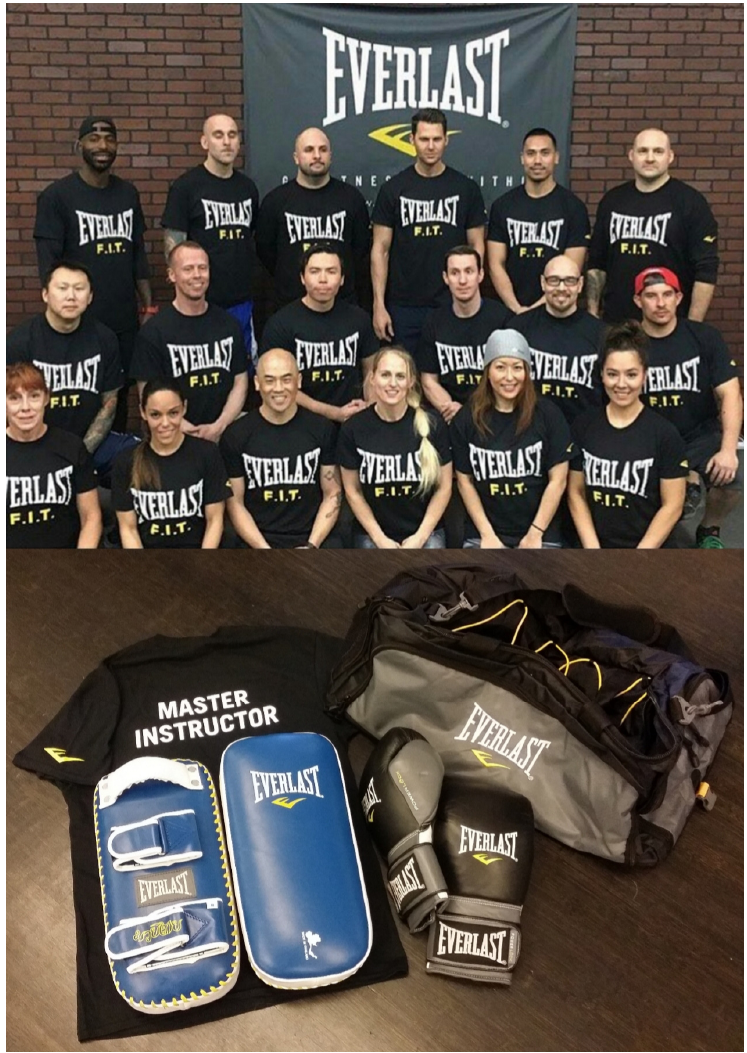
Figure 6. Muay Thai can contribute to personal accomplishments. The martial arts provide many opportunities for accomplishment as a student, partner, or competitor. There are many professional competitions that individuals can participate in to become amateur, professional, and master champi- ons (UFC, One Championship, WBC MuayThai, Lion Fight). There are also many other opportunities within the martial arts community to experience accomplishment, for example, by becoming a boxing coach or Master Instructor for a martial arts company or gym. Martial artists also experience more immediate forms of accomplishment by completing challenging training sessions and developing kinesthetic mastery over their own body. Since I have been practicing martial arts for over 30 years, being given the opportunity to teach the first Everlast Striking Specialist Level 1 course in my home- town of Redondo Beach, California, also gave me a great sense of accomplishment. The top photo shows the Everlast Master Instructor team at City Boxing Club in Las Vegas, Nevada. The bottom photo shows the assigned coaching gear for Everlast Master